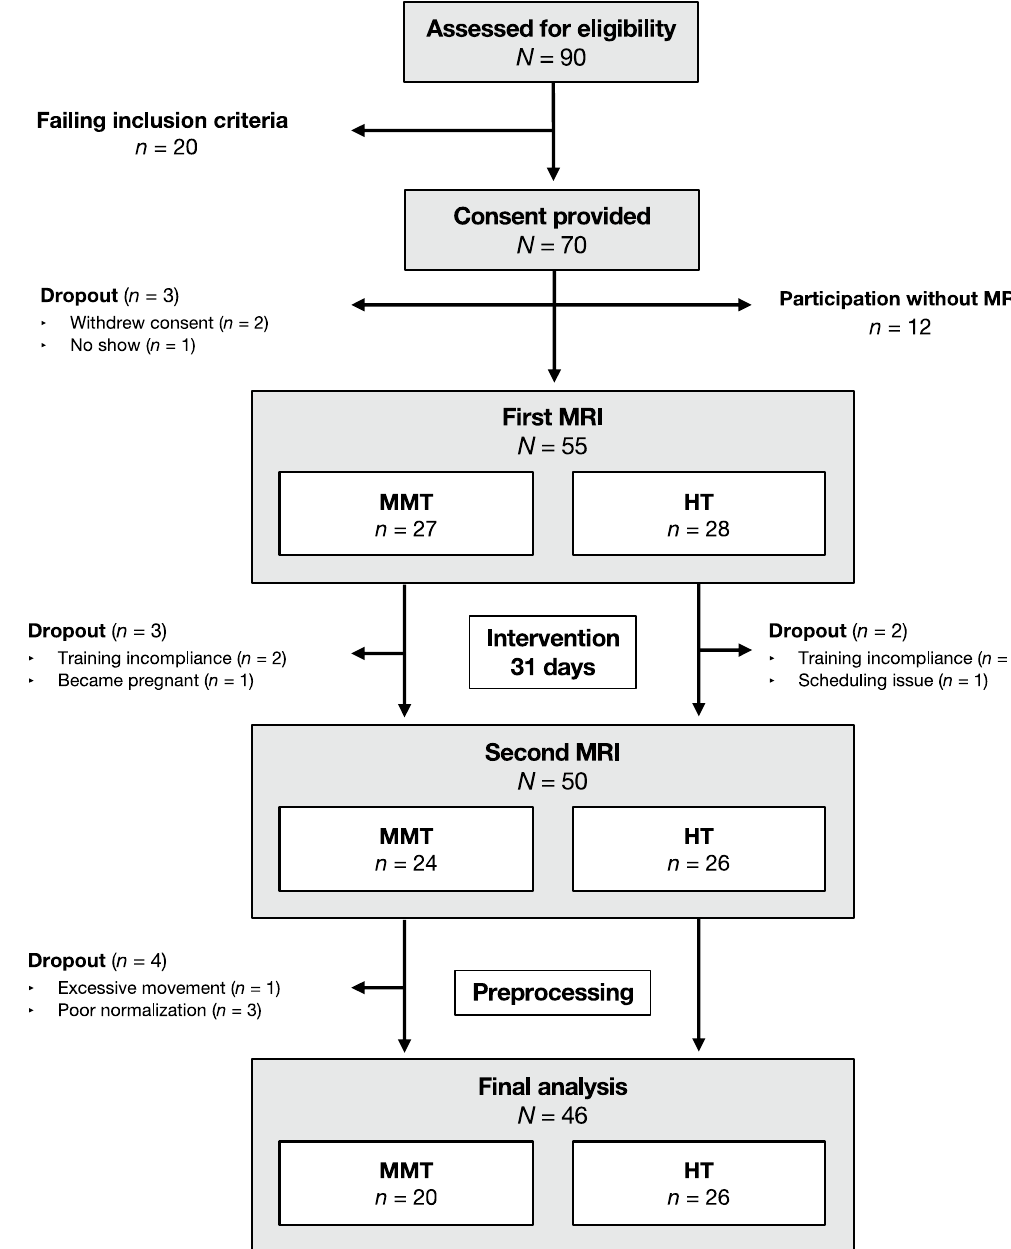
Figure 6. Data acquisition scheme and participant flow chart. MMT Mindfulness Meditation Training, HT Health